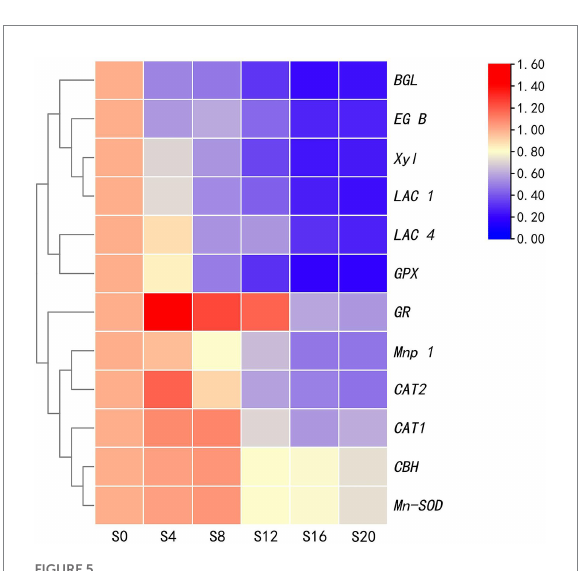
FIGURE 5 Relative expression of 12 genes of the subcultured Volvariella volvacea